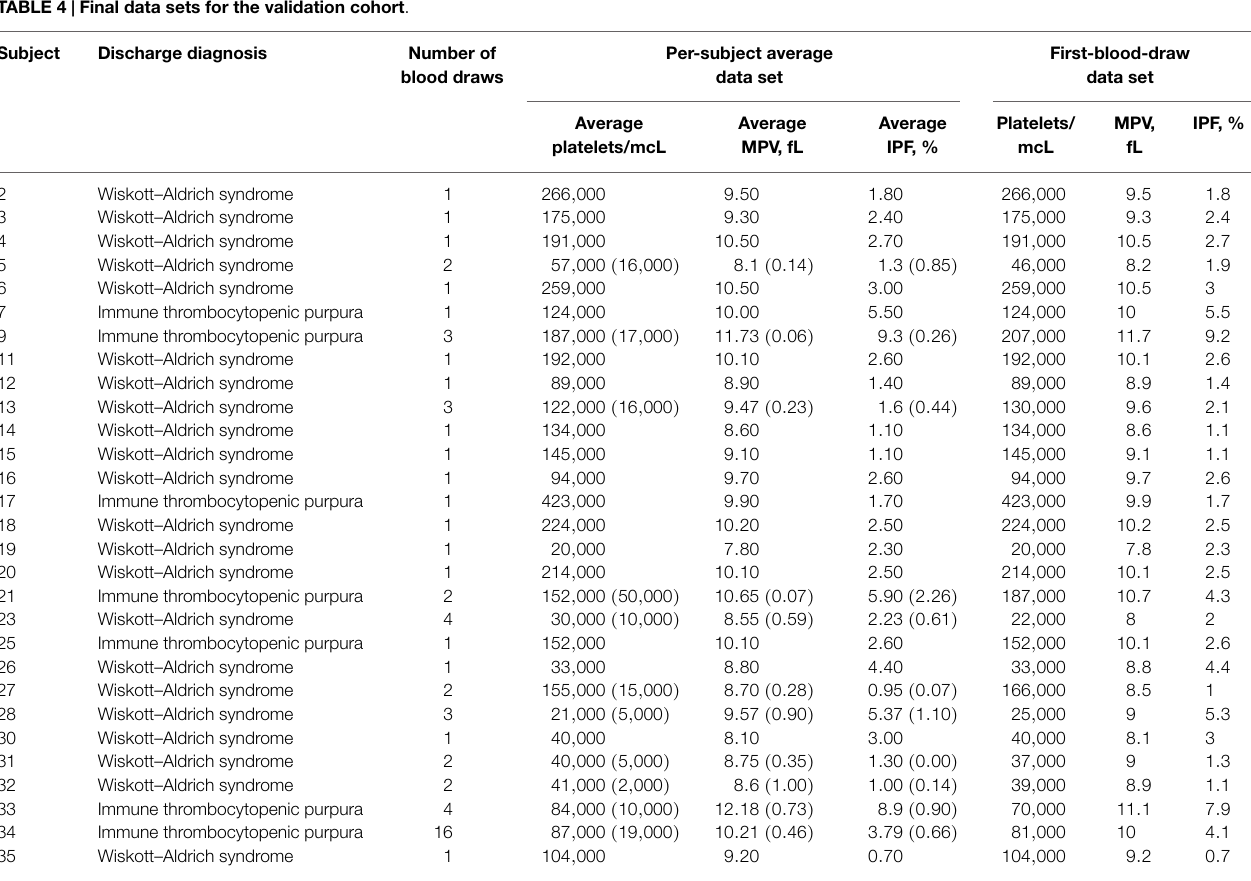
TABLE 4 | Final data sets for the validation cohort